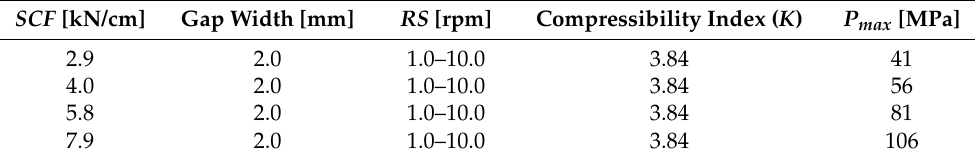
Table 1. Calculated P max for the compaction of MCC at different SCF and RS combinations.